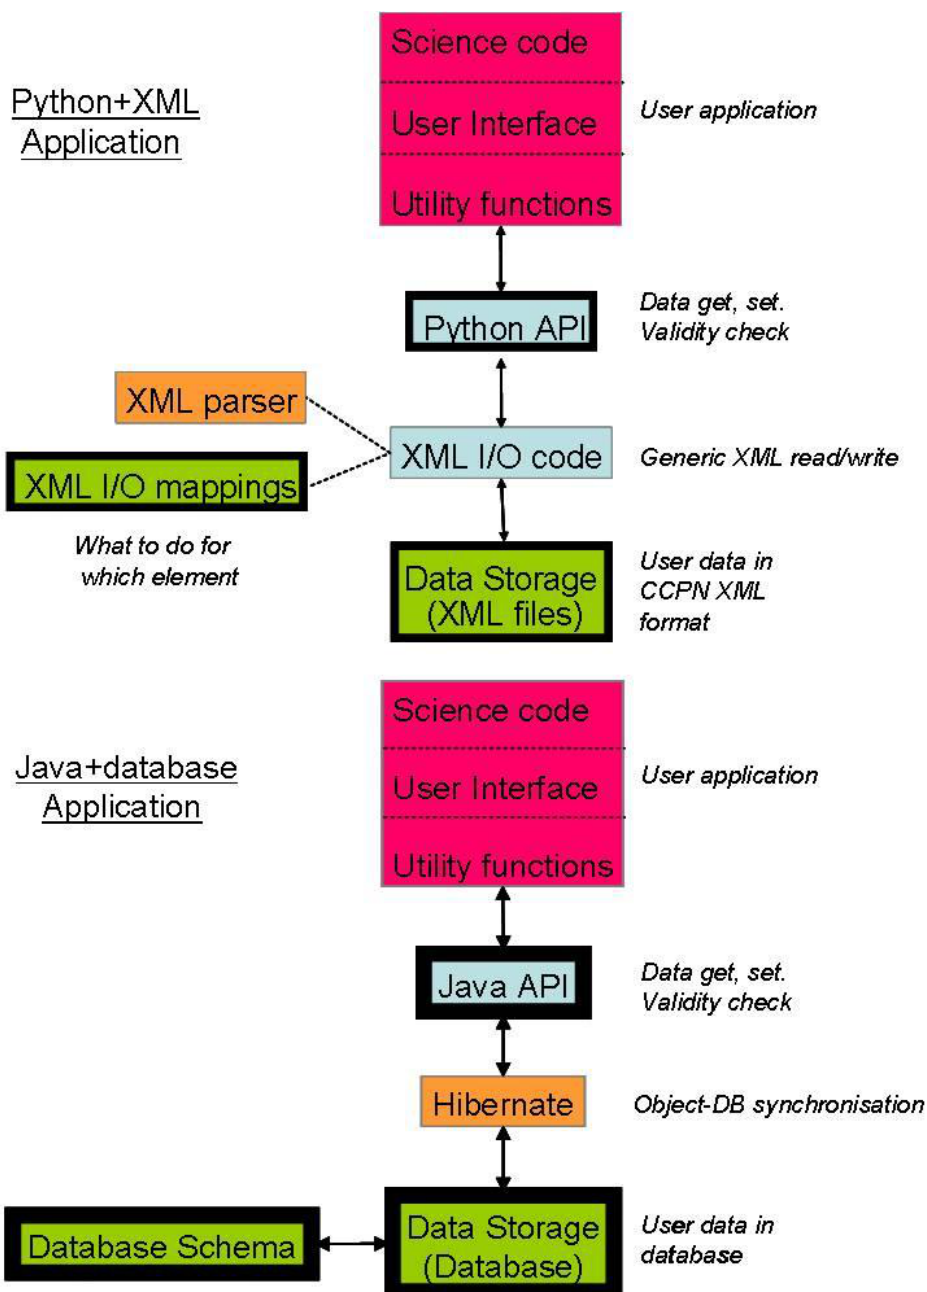
Supplementary Figure 6: Runtime code organization for an application using a Python+XML Implementation (top) or a Java+database implementation (bottom). CCPN software is in blue, external software is in orange, and code specific for the application is in red. Boxes with thick black borders are files generated by CCPN code. The application is connected to the API through an optional layer of utility functions. These execute common tasks that require extensive data model manipulations, e.g. ‘Create a molecule from a string of one-letter